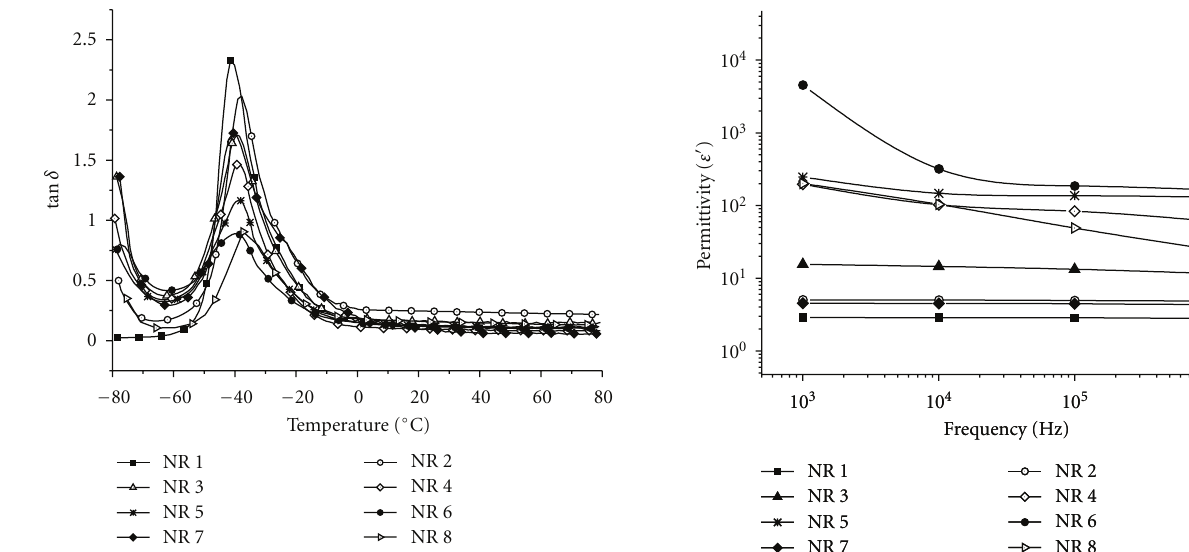
Figure 3: Frequency dependence of the dielectric permittivity ( ε (cid:3) ) for composites comprising di ff erent amounts of Printex XE-2B or Corax N220 at 30 ◦